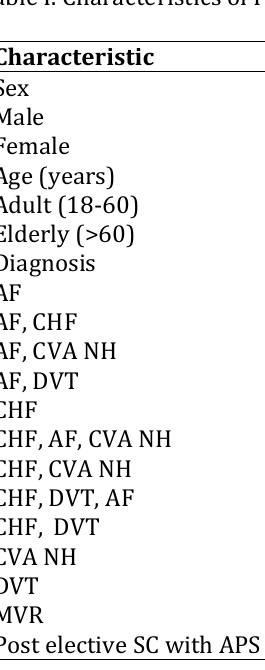
Figure 1. Flowchart of subjects in this retrospective cross-sectional study. Table I. Characteristics of